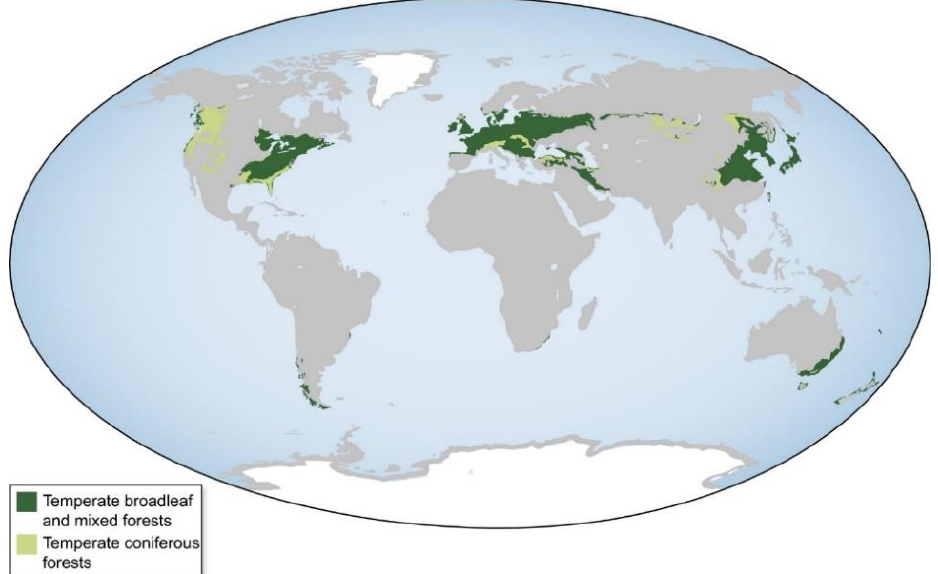
Figure 1. The distribution of temperate forests. Reprinted with permission from ref. [18]. Copyright 2016 Gilliam.